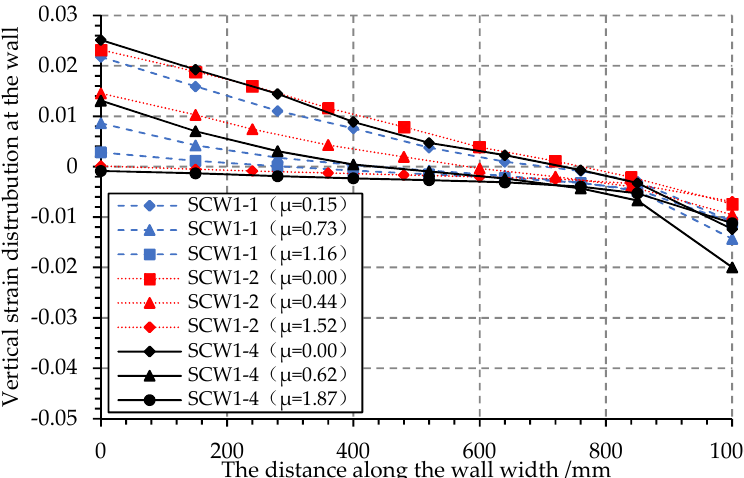
Figure 4. Vertical strain distribution at the wall base for specimens at ultimate load under different axial load ratios ( µ is the axial compression ratio).